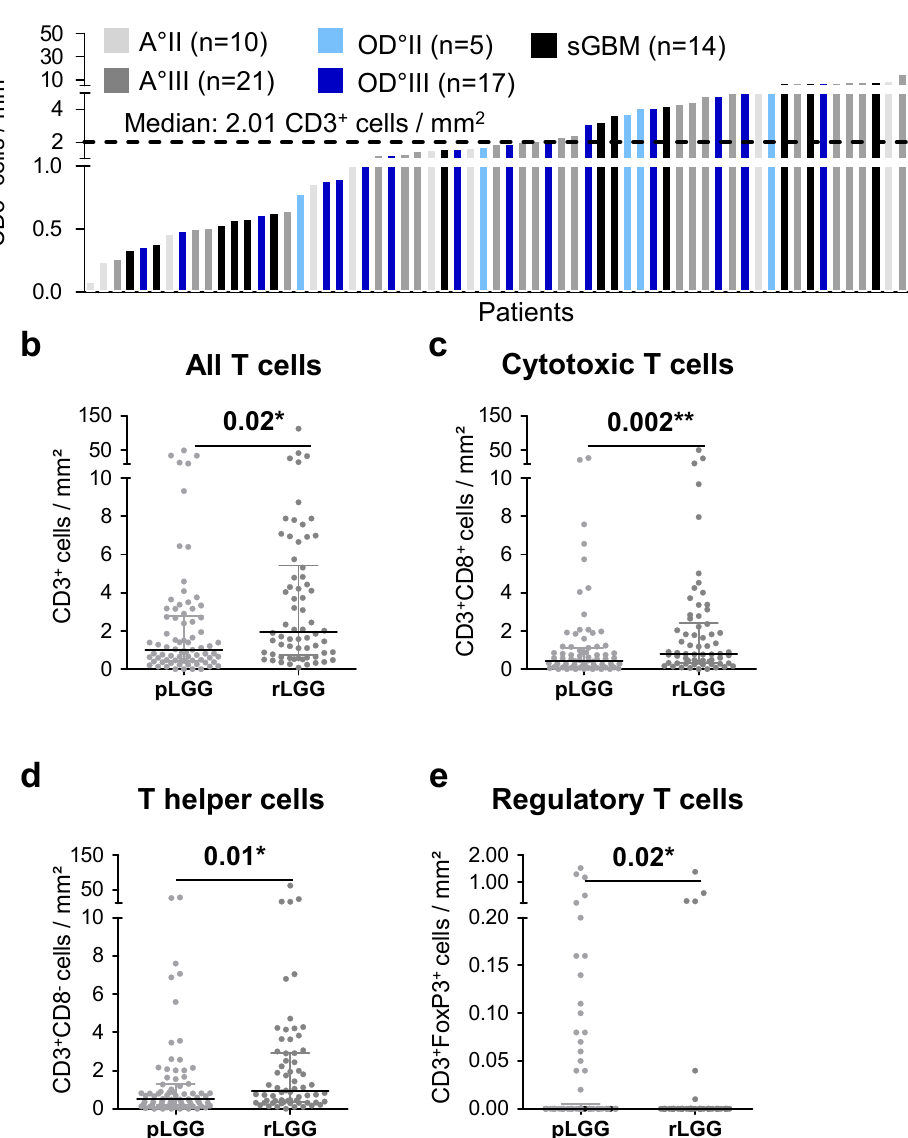
Figure 3. Changes in T-cell infiltration between primary and recurrent IDH mut gliomas: ( a ) Distribution of T-cell infiltration in recurrent IDH mut gliomas normalized to the area analyzed and color-coded for glioma subtype and WHO grade and ( b – e ) analysis of T-cell infiltration in primary and recurrent IDH mut gliomas for ( b ) all T cells, ( c ) cytotoxic T cells, ( d ) T helper cells, and ( e ) regulatory T cells. A, astrocytoma; OD, oligodendroglioma, sGBM, secondary glioblastoma; mm 2 , square millimeter; II, WHO grade II; III, WHO grade III; pLGG, primary LGG; rLGG, recurrent LGG; * p < 0.05; and ** p < 0.01.